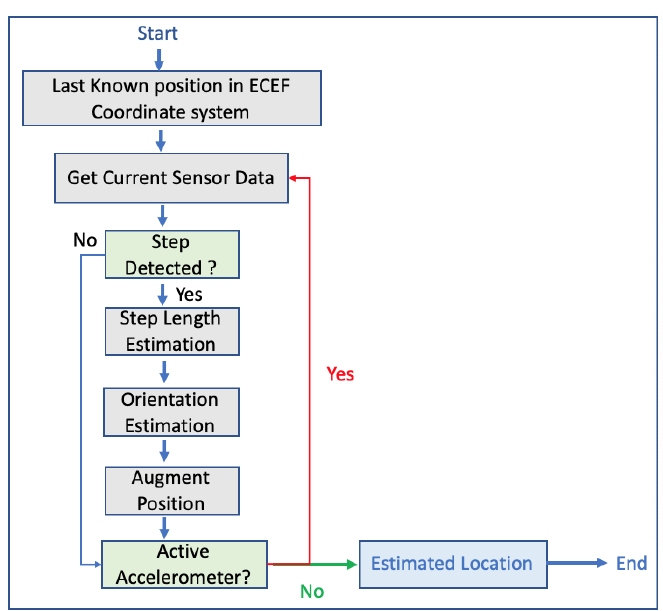
Figure 12. Hybrid location estimation solution as presented in Reference